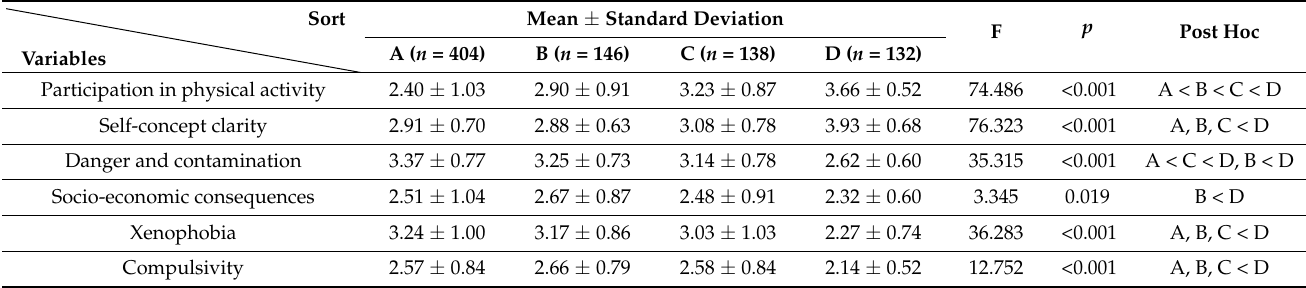
Table 10. Differences in each variable according to the duration of each physical activity session.